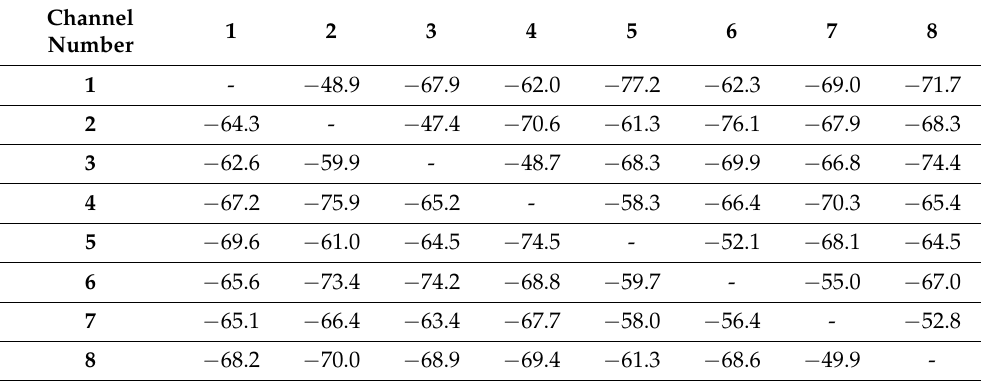
Table 1. Results related to channel mutual coupling.